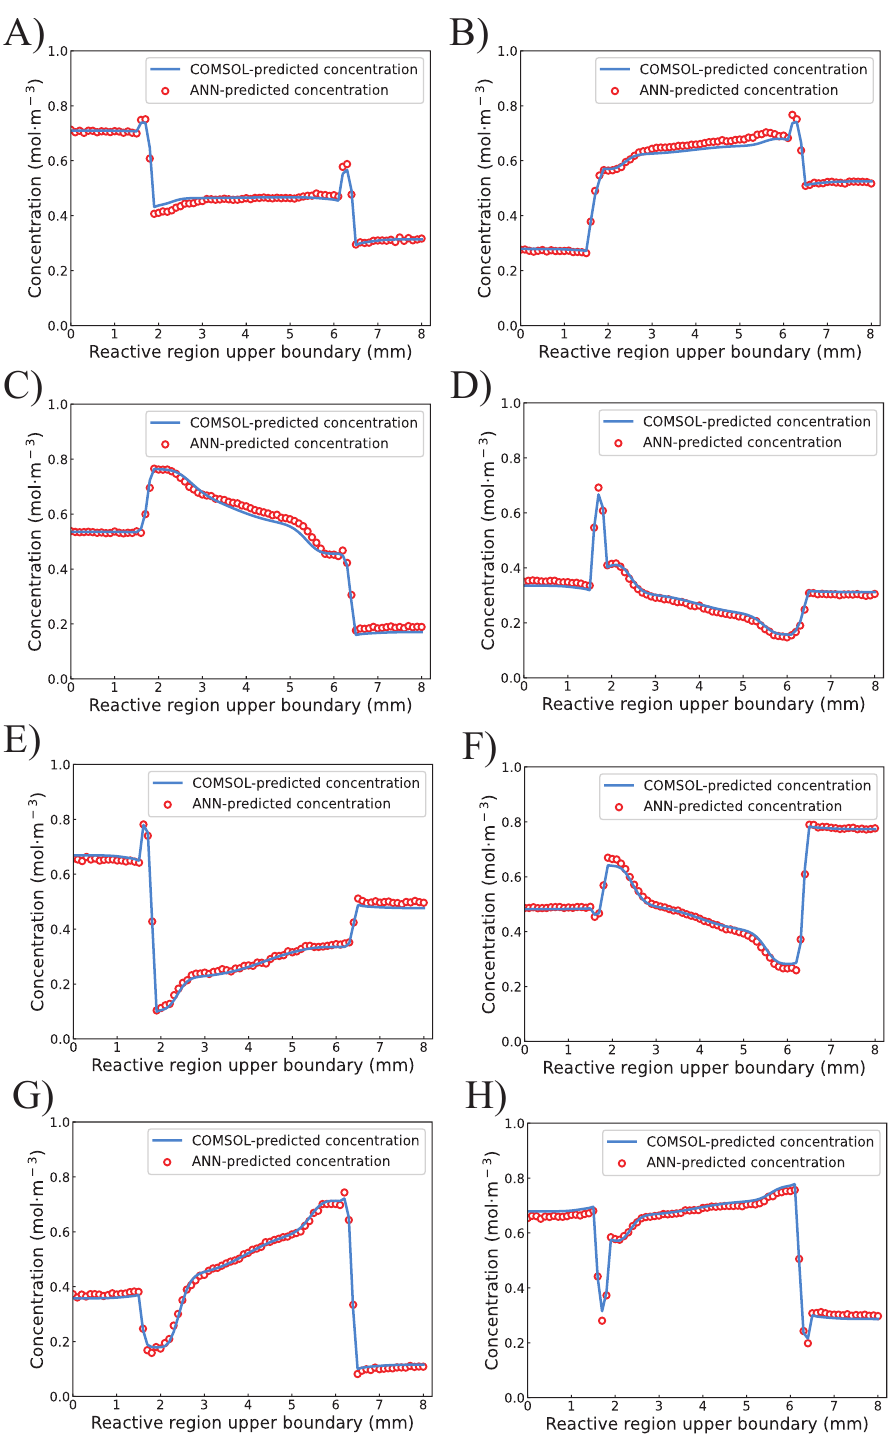
Figure 6. The comparision between ANN-predicted and COMSOL-predicted concentration values on the upper boundary of the reactive region from design ( A – H